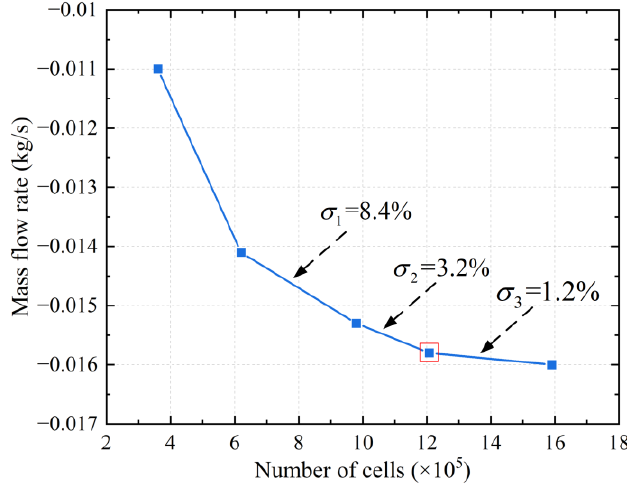
Figure 11. Outlet mass flow rate of different grid schemes.